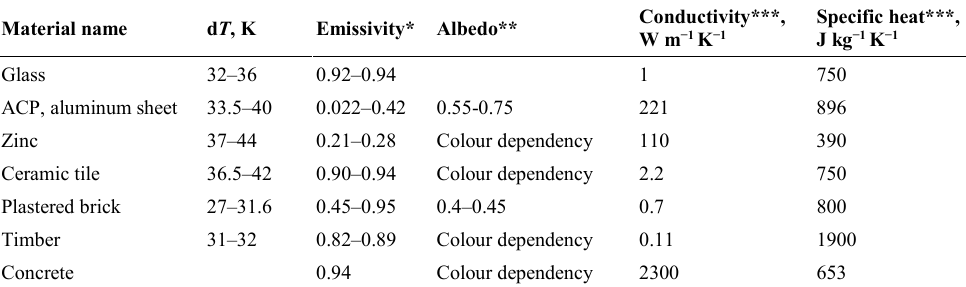
Fig. 4. Buildings’ facades along AS Street and the thermal infrared images taken on 26 th May 2018 with the micro weather station (MWC) installed on the yellow circle. T ABLE 2. R ADIATIVE AND T HERMAL P ROPERTIES OF THE M